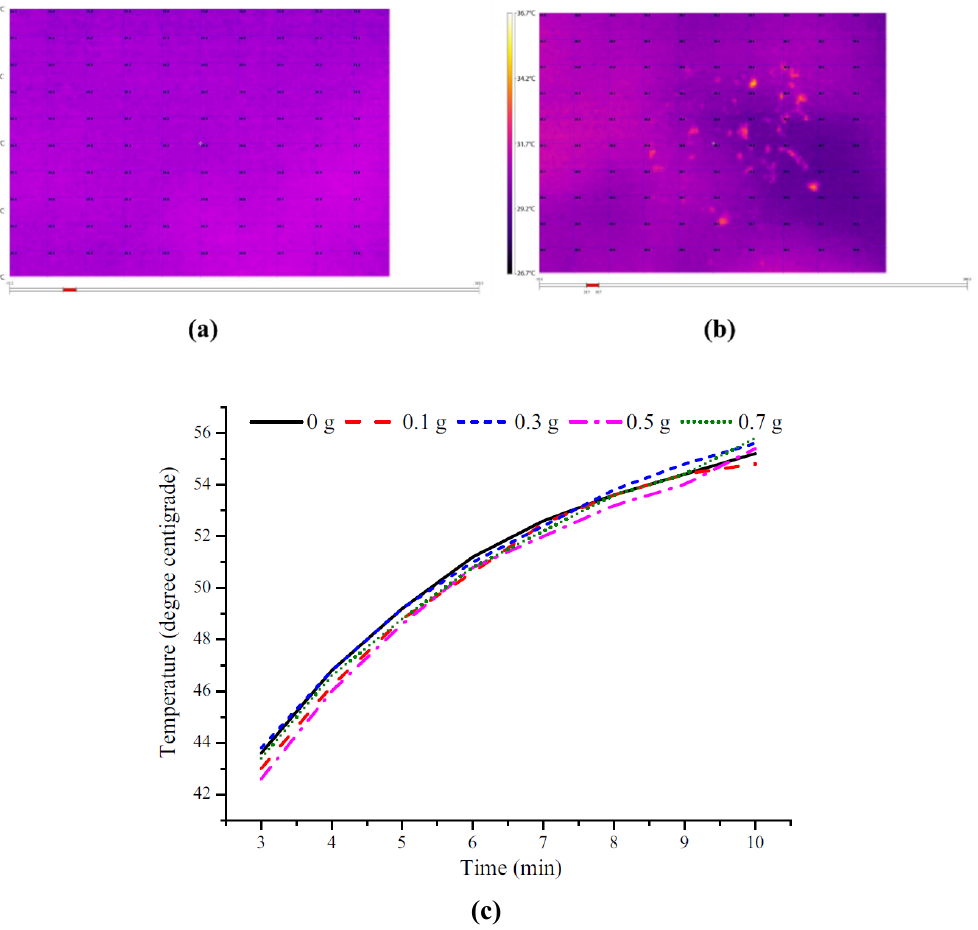
Figure 3. ( a ) Thermal investigation of a clean panel. ( b ) Thermal investigation of a non-uniform dust deposited panel [91]. ( c ) Working temperature of the PV panel with different weight of soil [28].